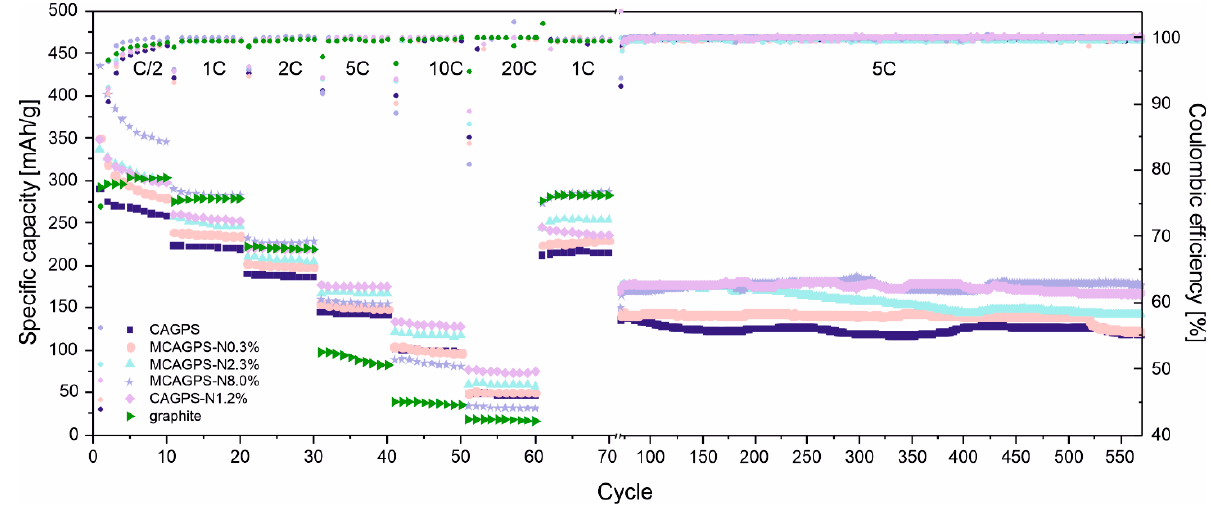
Figure 2. Galvanostatic charge–discharge tests of investigated samples in half-cells under different current loads (MCAGPS—carbon aerogel made from potato starch modified with melamine; CAGPS-N—carbon aerogel made from potato starch modified by N 2 pyrolysis; CAGPS—pristine carbon aerogel).